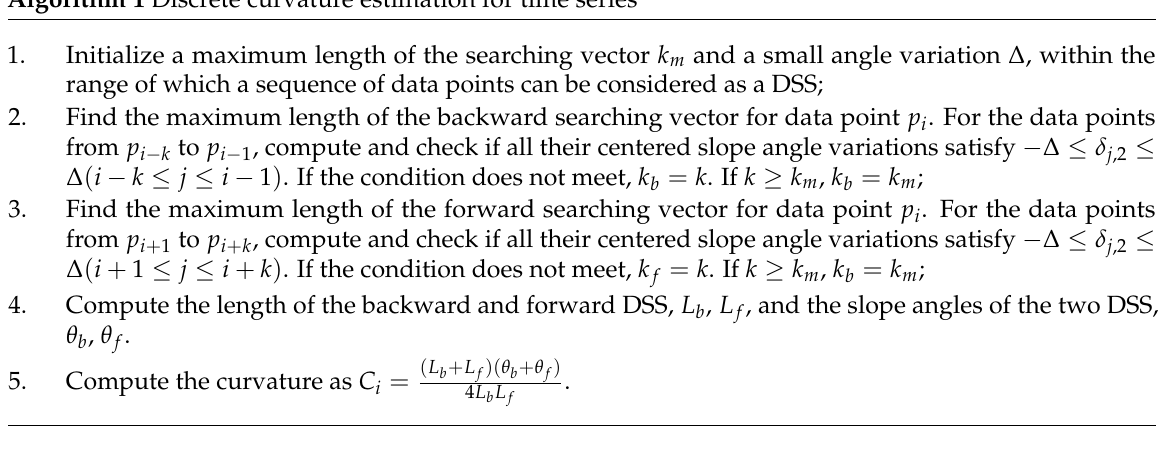
Algorithm 1 Discrete curvature estimation for time